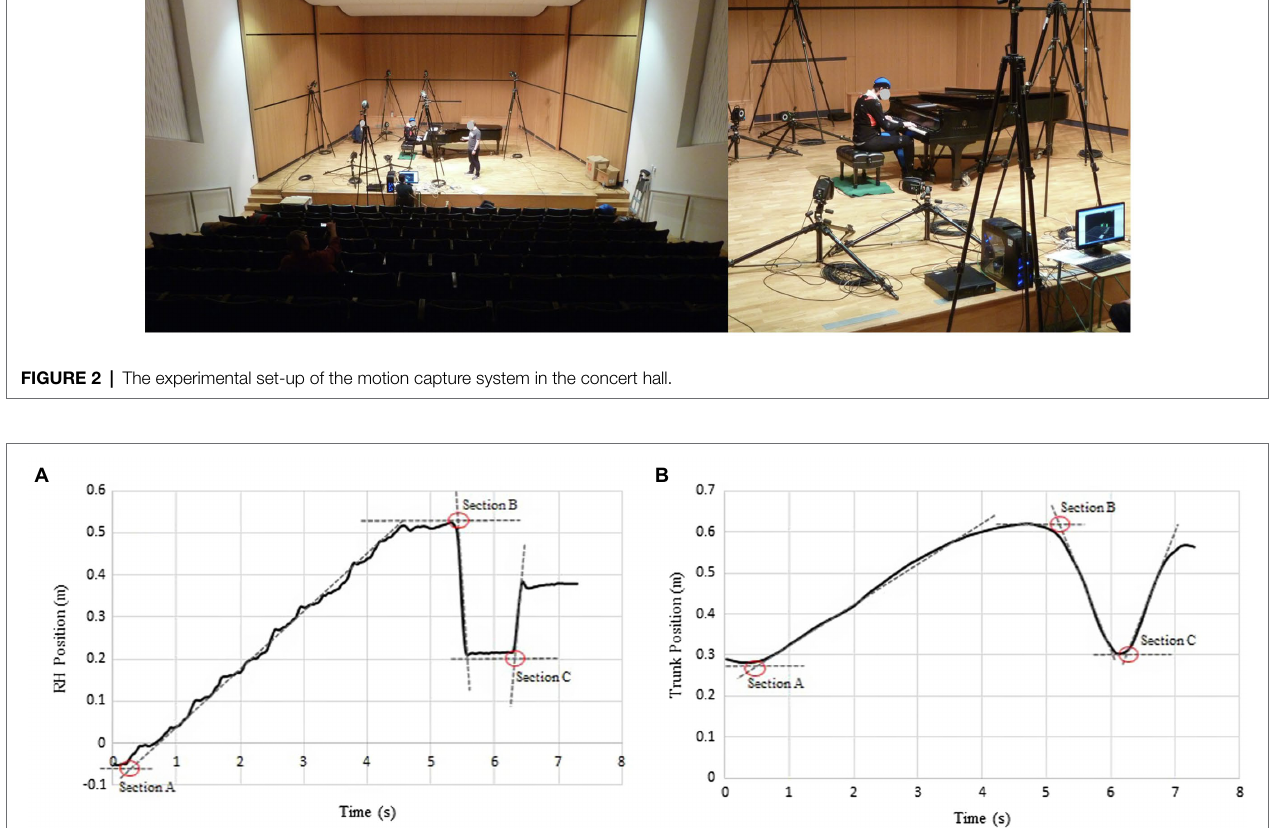
FIGURE 3 | (A,B) An example of the method used to calculate initiation time points. The intersection points between the initial position and positional slope (red circles) indicate the initiation time for the RH and trunk in each section of the musical